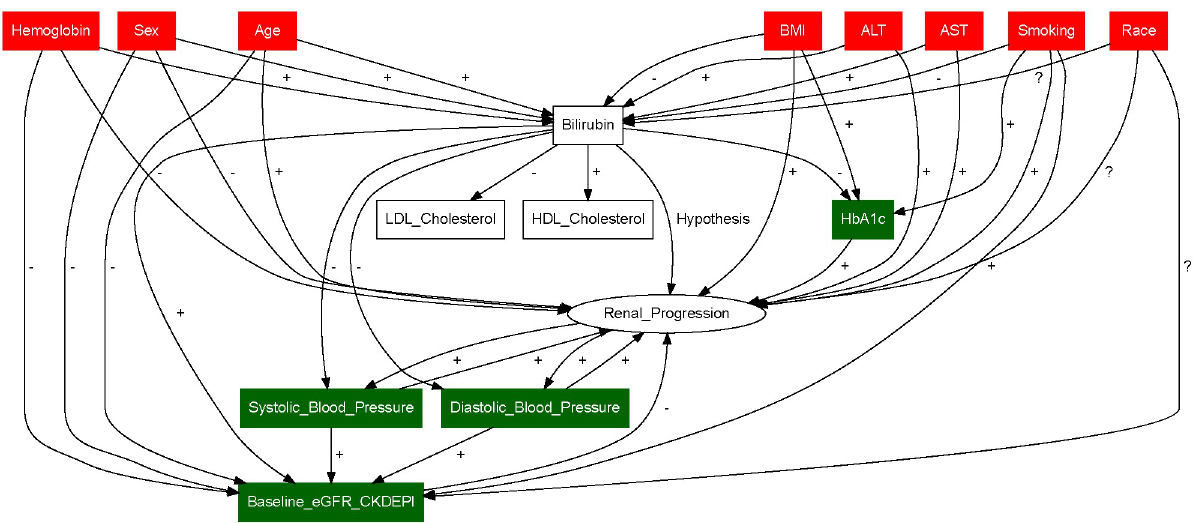
Fig 3. Directed Acyclic Graph (DAG) for the effect of serum bilirubin on renal progression. Arrows denote the known or suspected causal effect (regardless of the effect size). Red nodes are the covariates that are identified as confounders, and green nodes are the covariates that are identified to be mediators. As the total effects of the bilirubin are our interest, we adjust only for confounders and not for mediators. +—and? indicate the positive, negative and unspecific known or suspected causal association.